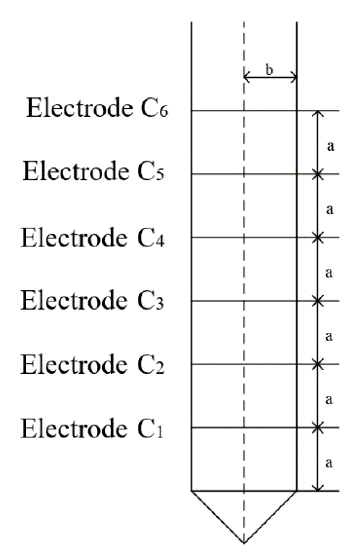
Figure 11. Multi-electrode ring probe.